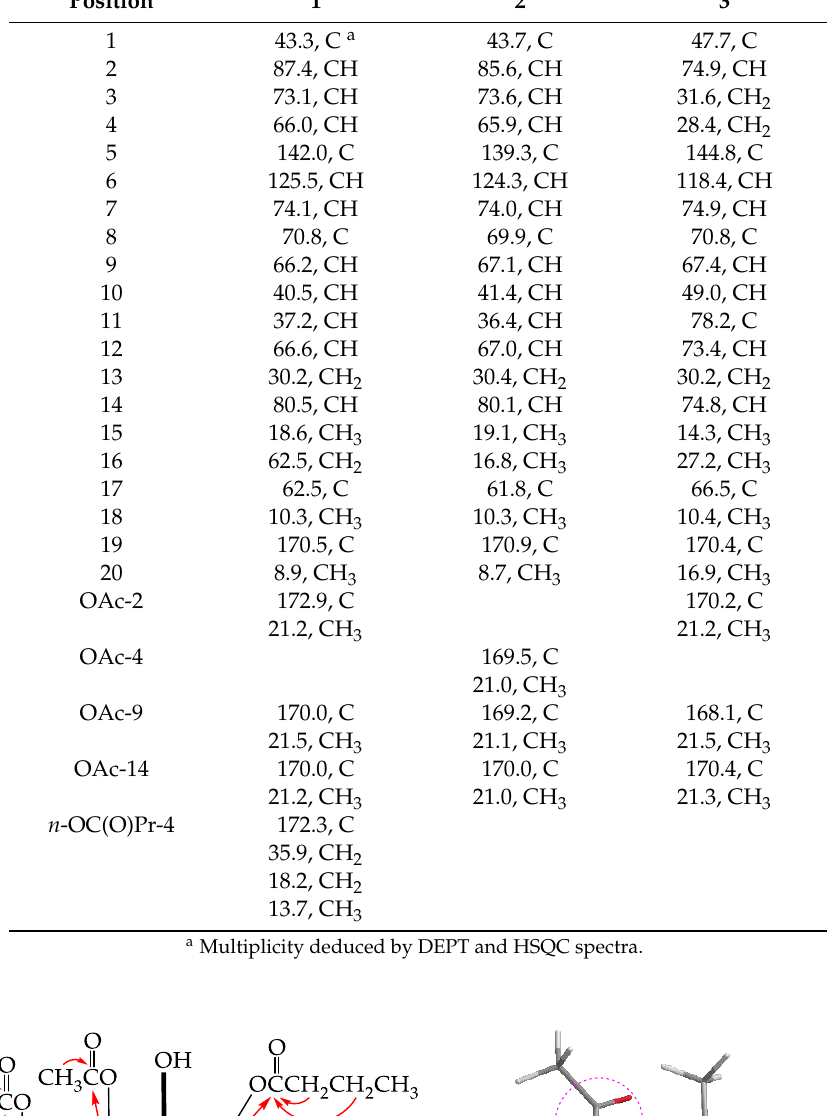
139.3 (C-5) and 124.3 (CH-6). A methyl-containing tetrasubstituted epoxy group was confirmed from the signals of two oxygenated quaternary carbons at δ C 69.9 (C-8) and 61.8 (C-17), and from the chemical shift of a tertiary methyl (δ H 1.66, 3H, s; δ C 10.3, CH 3 -18; Tables 1 and 2). Four carbonyl resonances at δ C 170.9, 170.0, 169.5, and 169.2 in the 13 C spectrum confirmed the presence of a γ-lactone iNOS COX-2 β-Actin